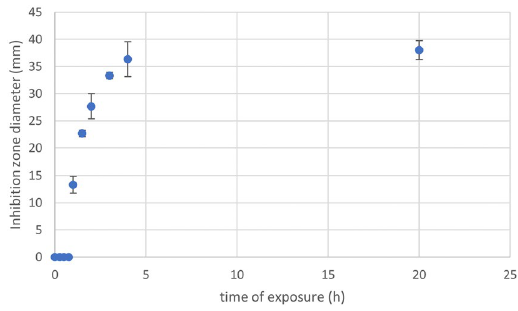
Figure 6. Allicin (20 µ L droplet of 80 mM solution) shows inhibitory effects against E. coli in this test dependent on exposure time, with maximum inhibition reached after only four hours